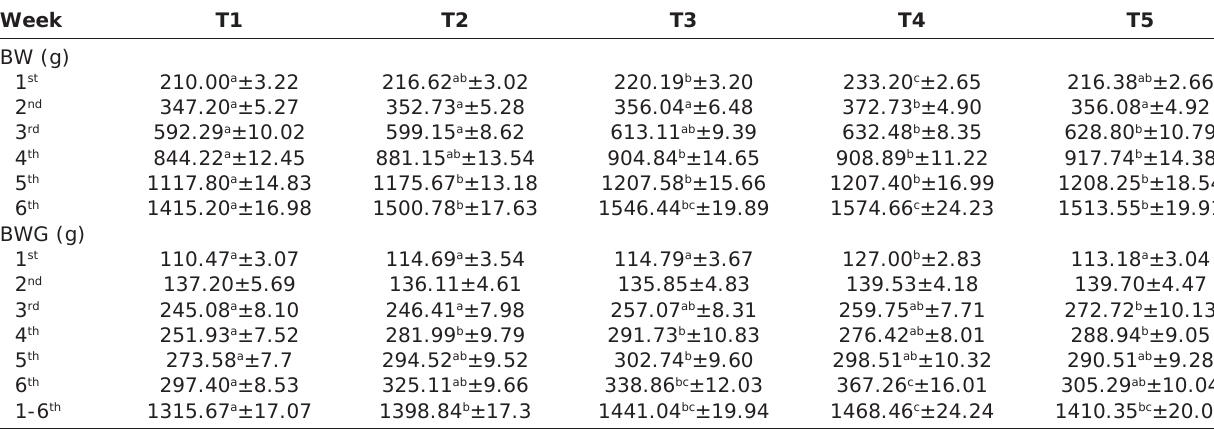
Table-5: Effect of dietary supplements of herbs/spices on average BW (g) and average BWG (g) at weekly interval in broilers. Week